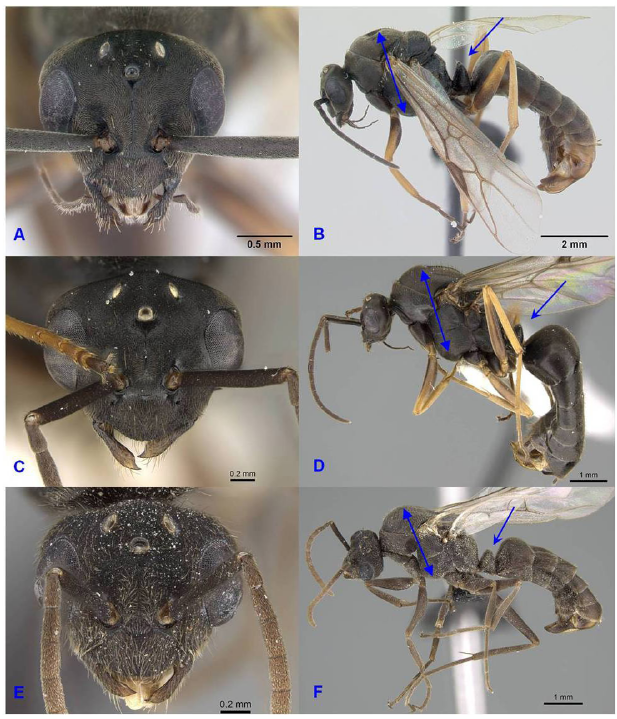
Fig 3 . Males of Formica fusca (A, B) [CASENT0178770], Formica gerardi (C, D) [XE00205-3] and Iberoformica subrufa (E,